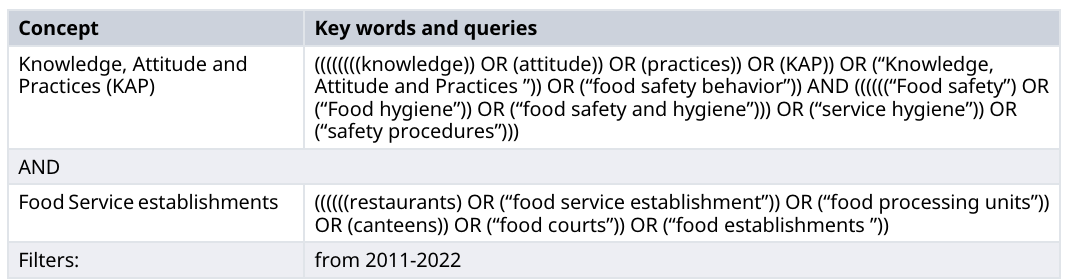
Table 1. Preliminary Search Strategy for